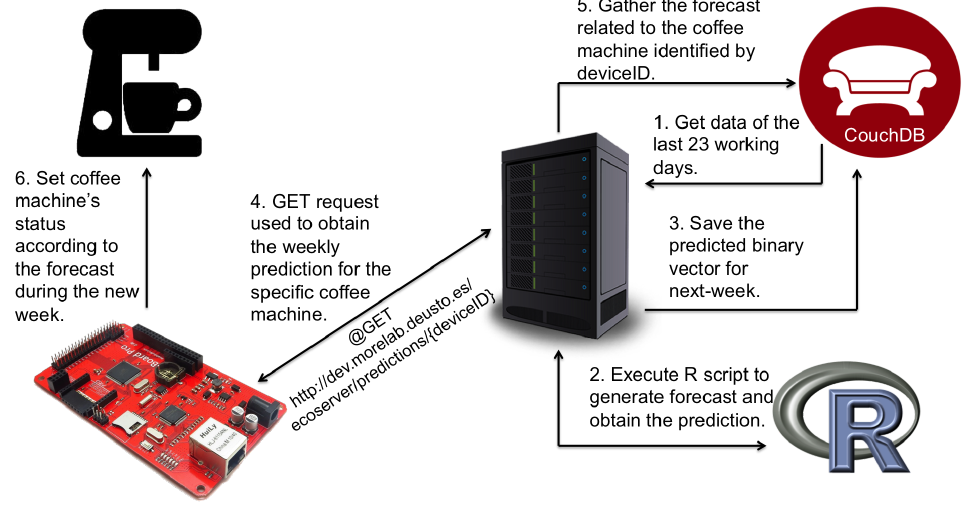
Figure 2. System architecture of the Coffee Machine use-case